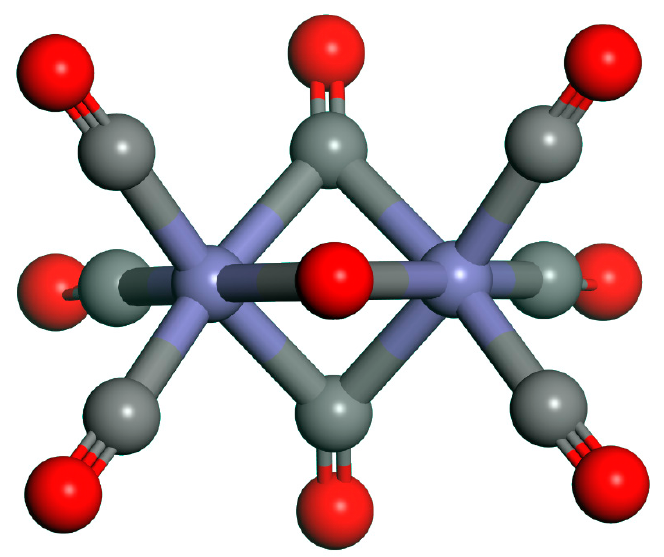
Figure 1. The structure of Fe 2 (CO) 9